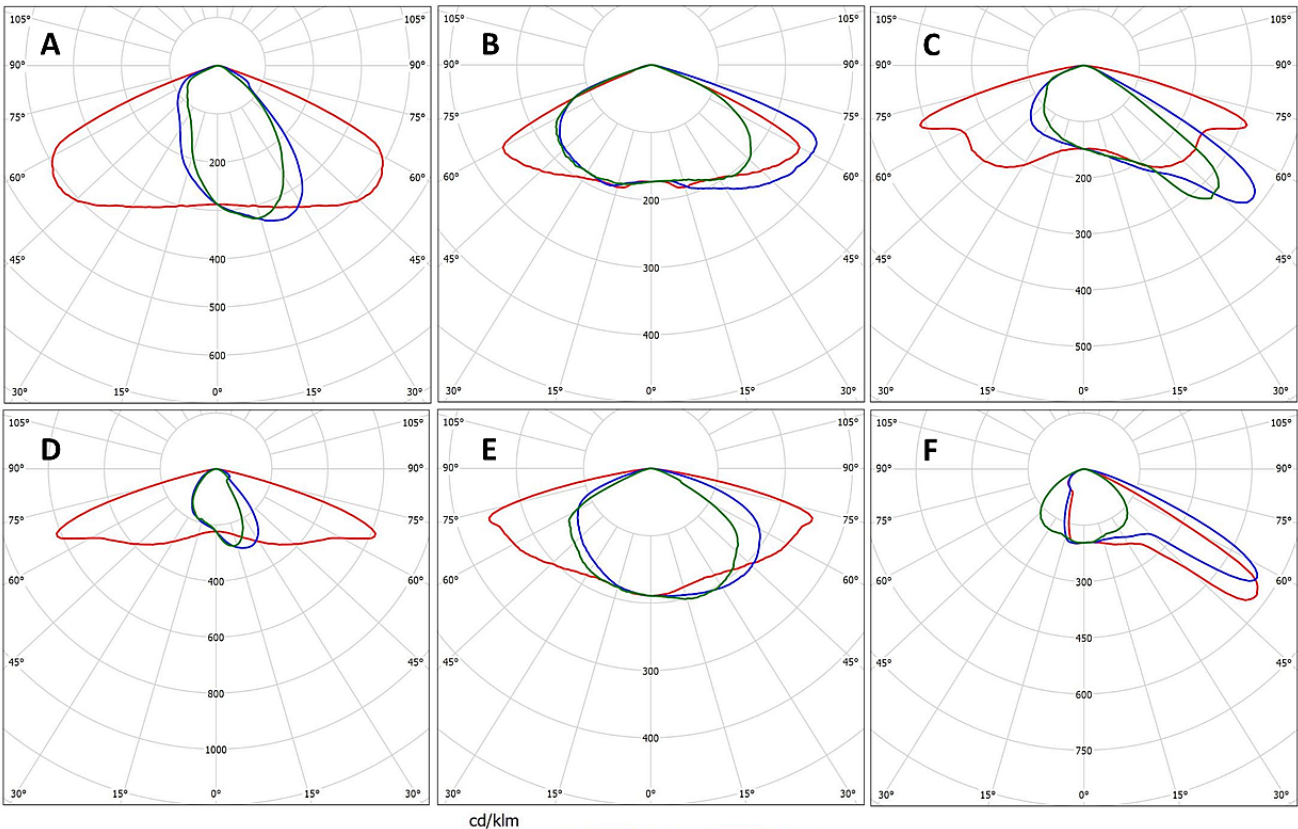
Figure 4. Luminous intensity distribution curves of the LED luminaire used (types ( A – F )).